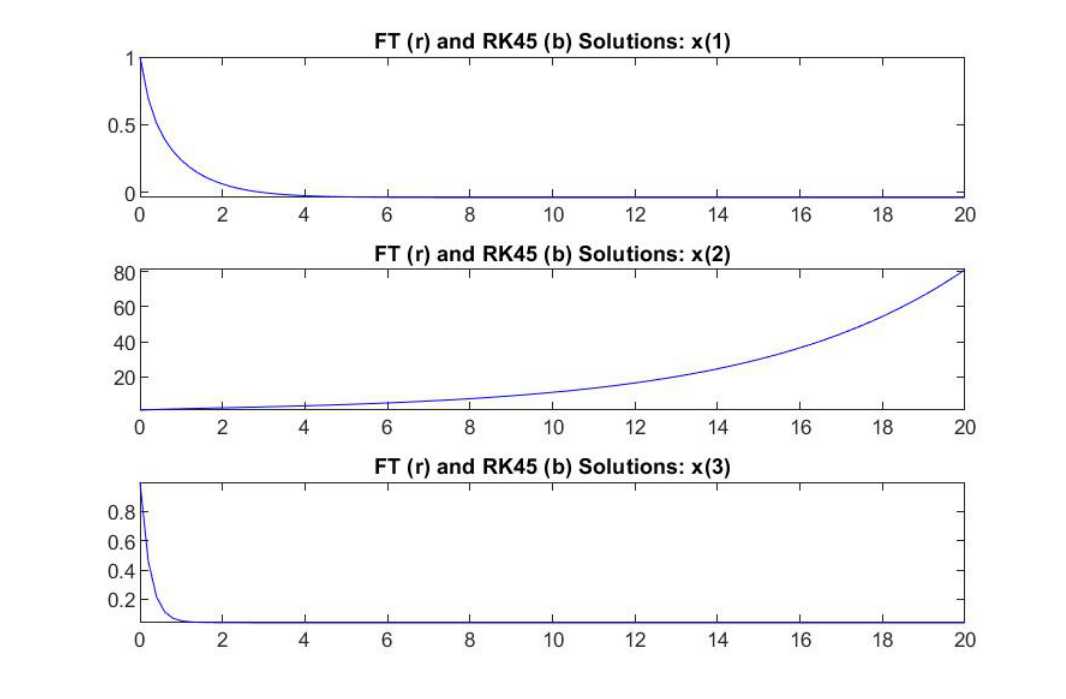
Figure 4. Problem No3 (Rössler system):The three components x j ( t ) , j = 1,2,3 are displayed in the order from top to bottom; FT solution is red-colored, RK solution is